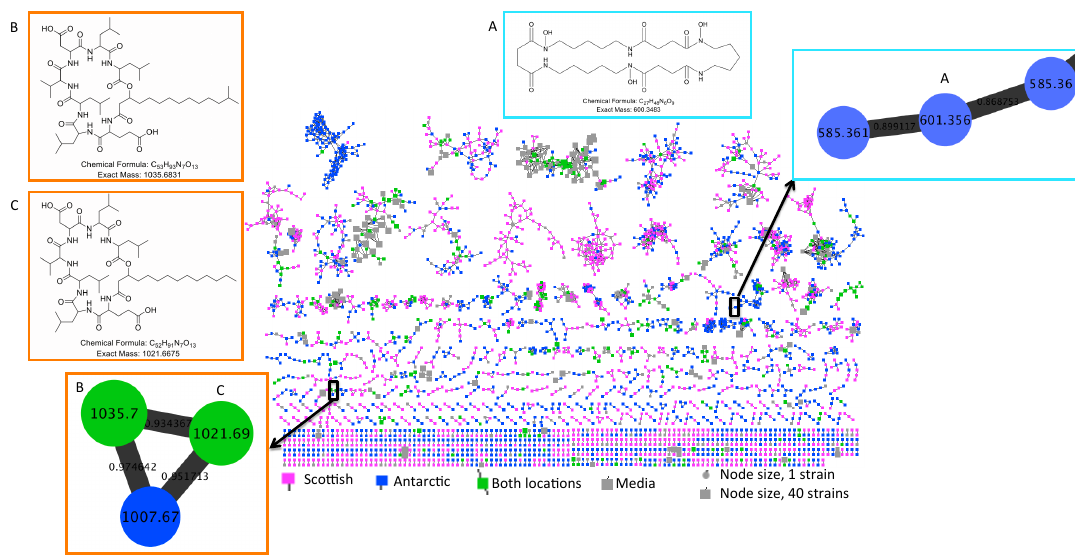
Figure 2. Molecular network of 3,558 parent ions produced by 38 bacterial strains. Nodes colours are based on bacterial isolation location, where nodes representing parent ions are produced by strains isolated from Antarctic sediment, Scottish sediment or both. Grey nodes represent media components and the node size reflects the number of strains that produced each parent ion. Nodes highlighted in coloured boxes represent parent ions that are identified as the previously discovered metabolites A) desferrioxamine E B) surfactin C14 and C) surfactin C15.